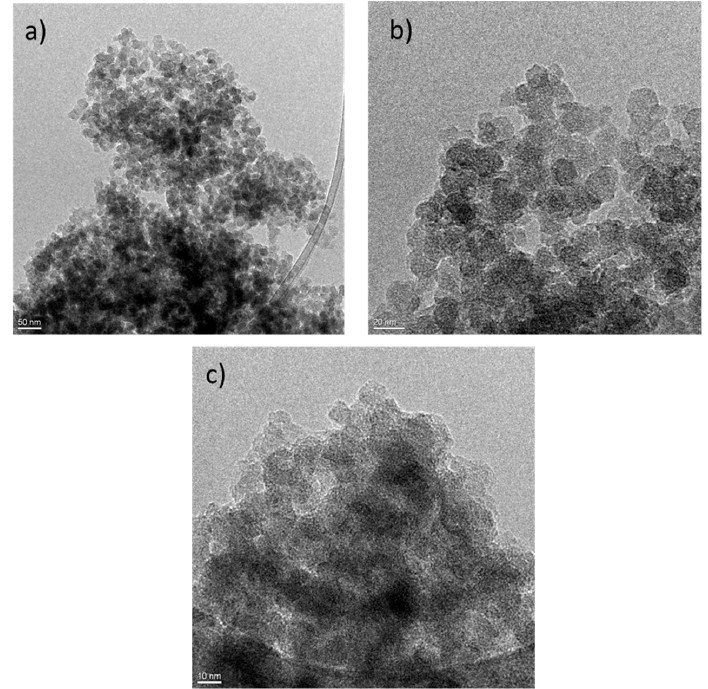
Figure 7. TEM images of Si-TriAm-CD-Cu-two times reused ( a , b ) Si-TriAm-CD-Cu ( c ).